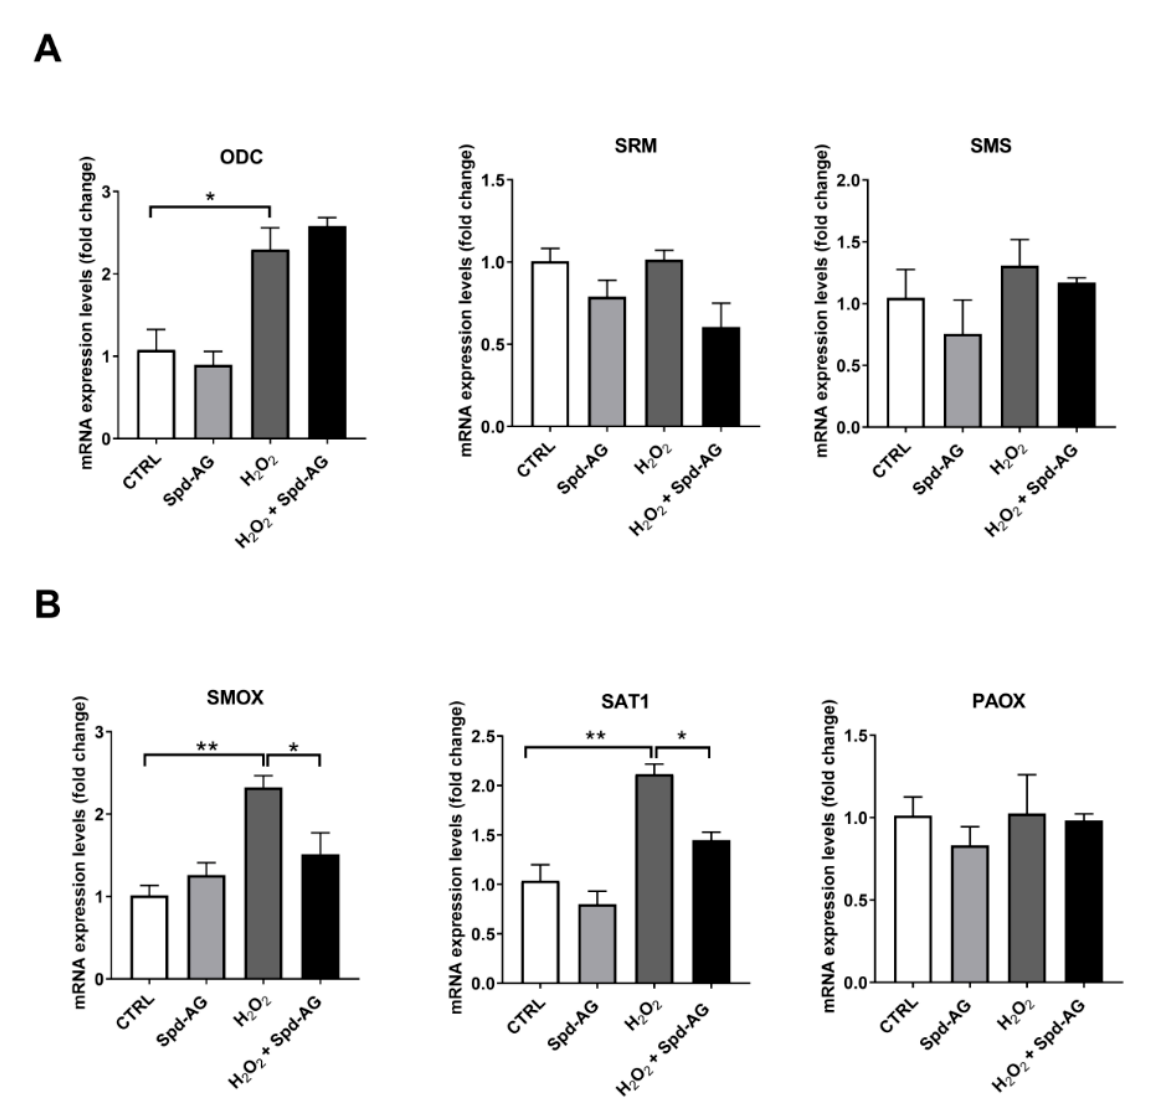
Figure 10. Effect of Spd-AG and H 2 O 2 on the expression level of polyamines enzymatic pathway. C2C12 were treated with Spd 10 µ M in combination with AG 1 mM and/or H 2 O 2 0.3 mM for 6 h and RNA transcript expression of the polyamine enzymatic pathway was evaluated. qRT-PCR of biosynthetic enzymes ( A ) ornithine decarboxylase (ODC), spermidine synthase (SDS), spermine synthase (SMS), or catabolic enzymes ( B ) spermine oxidase (SMOX), spermine-/spermidine-N1- acetyltransferase 1 (SAT1) and polyamine oxidase (PAOX) amplified from C2C12 myoblasts were assayed. Data are calculated relative to the internal housekeeping gene (GAPDH) and are expressed as the mean fold change compared with control. Each value represents the mean ± SEM of three independent experiments, each performed in triplicate. One-way ANOVA followed by Bonferroni’s multiple comparisons test was performed * p < 0.05; ** p < 0.01.